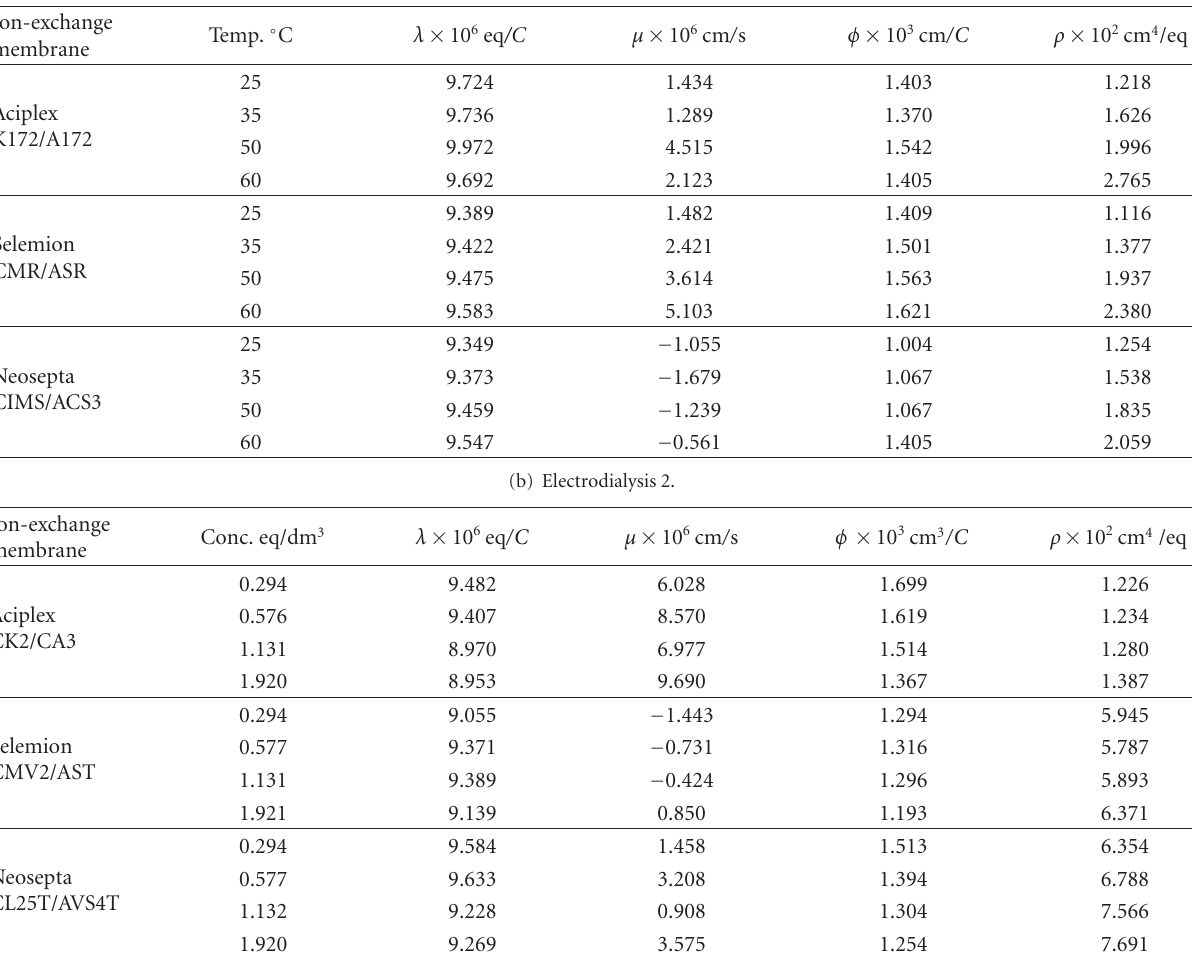
Table 2: Overall membrane pair characteristics. (a) Electrodialysis 1.